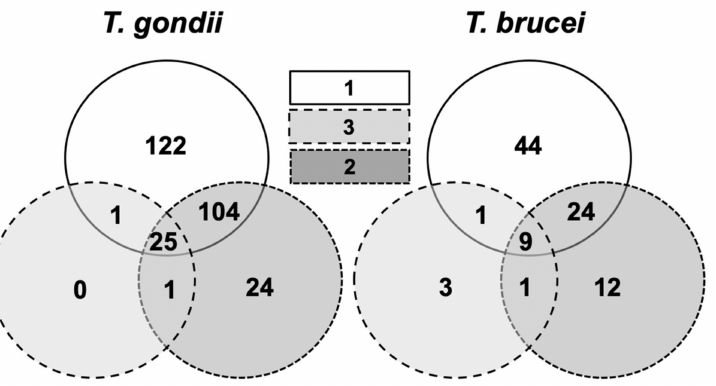
Figure 7. Venn diagram detailing the number of proteins from differential pull-downs. Pull-down fractions of extracts from T. gondii and T. brucei from 1, 2, and 3 columns were compared by MS shotgun analysis as described in Materials and